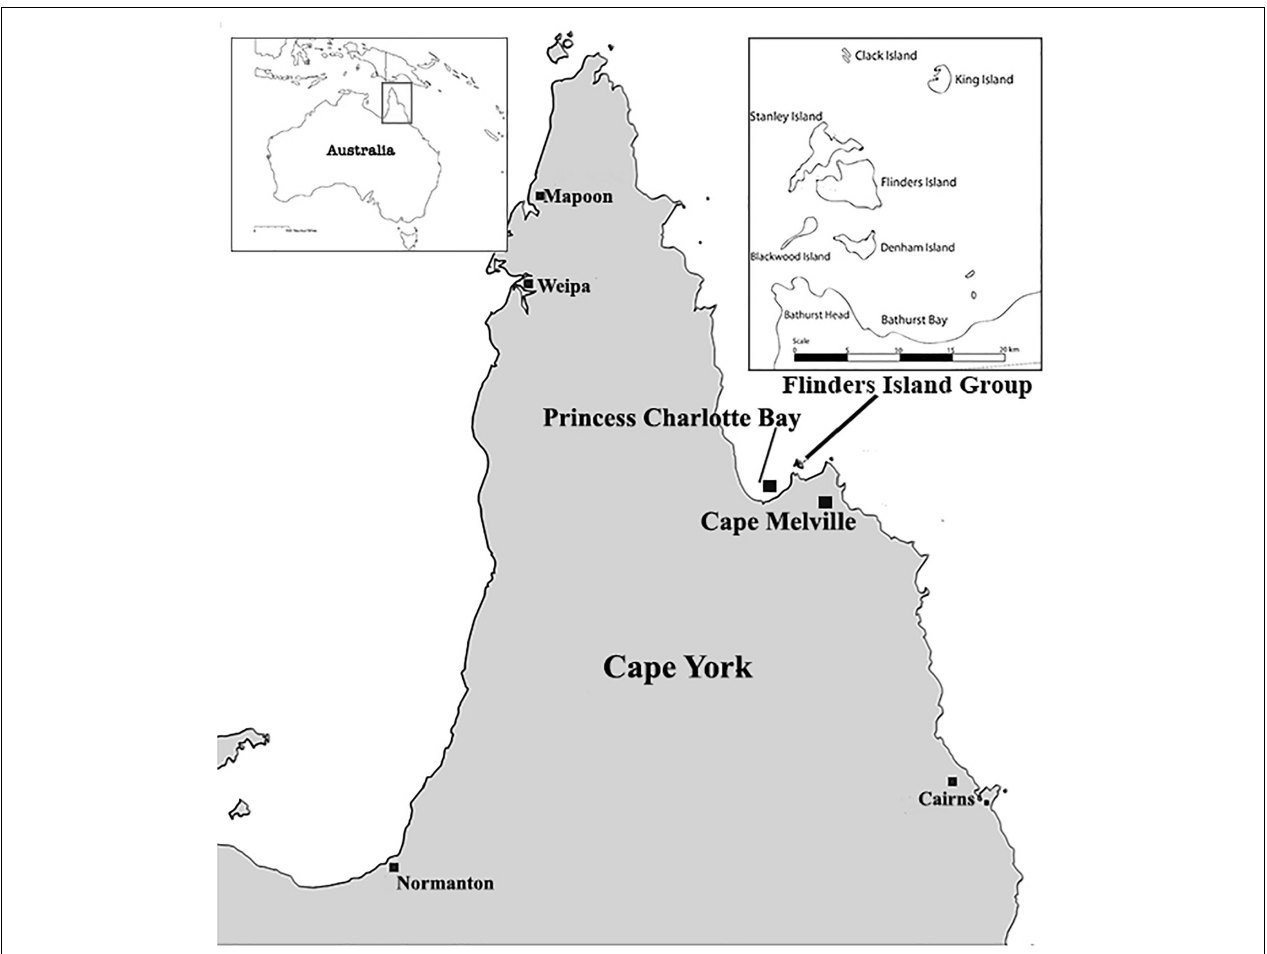
FIGURE 1 | Map of Cape York, showing the Flinders Island group location in the tropical north-east of Queensland off the eastern coast of Cape